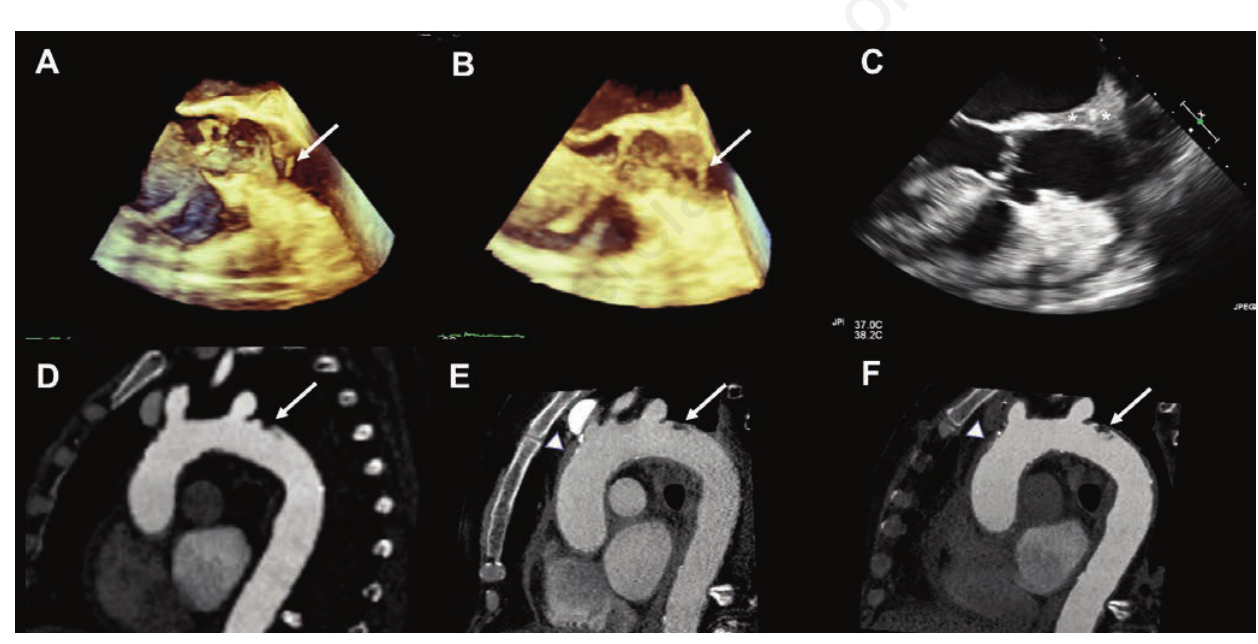
Figure 1. TEE (A-C) of the ascending aorta and aortic valve, and ECG-gated iodine-contrast enhanced CT angiography of the thoracic aorta (D-F) from three different time points. A) Three-dimensional TEE at initial examination. Two mobile structures were seen; one in the ascending aorta and one in the aortic arch. The white arrow indicates the 8 mm mobile structure in the ascending aorta at an atherosclerotic plaque approximately 3 cm above the aortic valve suspected to be a vegetation. B) Three-dimensional TEE a week after treatment. White arrow shows unchanged size of the mobile structure in the ascending aorta. C) Two-dimensional TEE a month after initiated treatment. The mobile structure in the ascending aorta has regressed and is not visible, but the aortic wall was thickened (*) which indicated a possible infective abscess. At examination 2 months after initiated treatment the vegetation and the thickened wall in the ascending aorta had fully regressed, but the mobile structure in the aortic arch was unchanged. D) CT angiography of the aorta at initial examination. Several partly calcified plaques were seen in the thoracic aorta. About 3 cm above the aortic valve a low attenu- ating 2 x 2 mm large structure protruding into the aortic lumen was seen. The aortic wall was thickened in the ascending aorta and the aortic arch. In the aortic arch just distal of the left subclavian artery a partly calcified plaque with a low attenuating mobile structure of about 3 mm attached was seen (white arrow). No abscess was present. E) CT angiography of the aorta one week after initiated treat- ment. The mobile structures in the ascending aorta and the aortic arch (white arrow) were unchanged. The thickening of the aortic wall (white arrowhead) persisted, however with some progress in the aortic arch wall, suggesting progress in the infective aortitis. No abscess was present. F) CT angiography of the aorta one month after initiated treatment. The mobile structure in the ascending aorta was hard- ly identifiable and the structures in the aortic arch (white arrow) were unchanged. The thickening of the aortic wall (white arrowhead) and the aortic arch wall had progressed even further with increased thickening of the aortic wall at the aortic root dorsally of the left atrium. No abscess was present. At examination one and a half months after initiated treatment the aortic wall thickening had regressed and the mobile structure in the ascending aorta was not